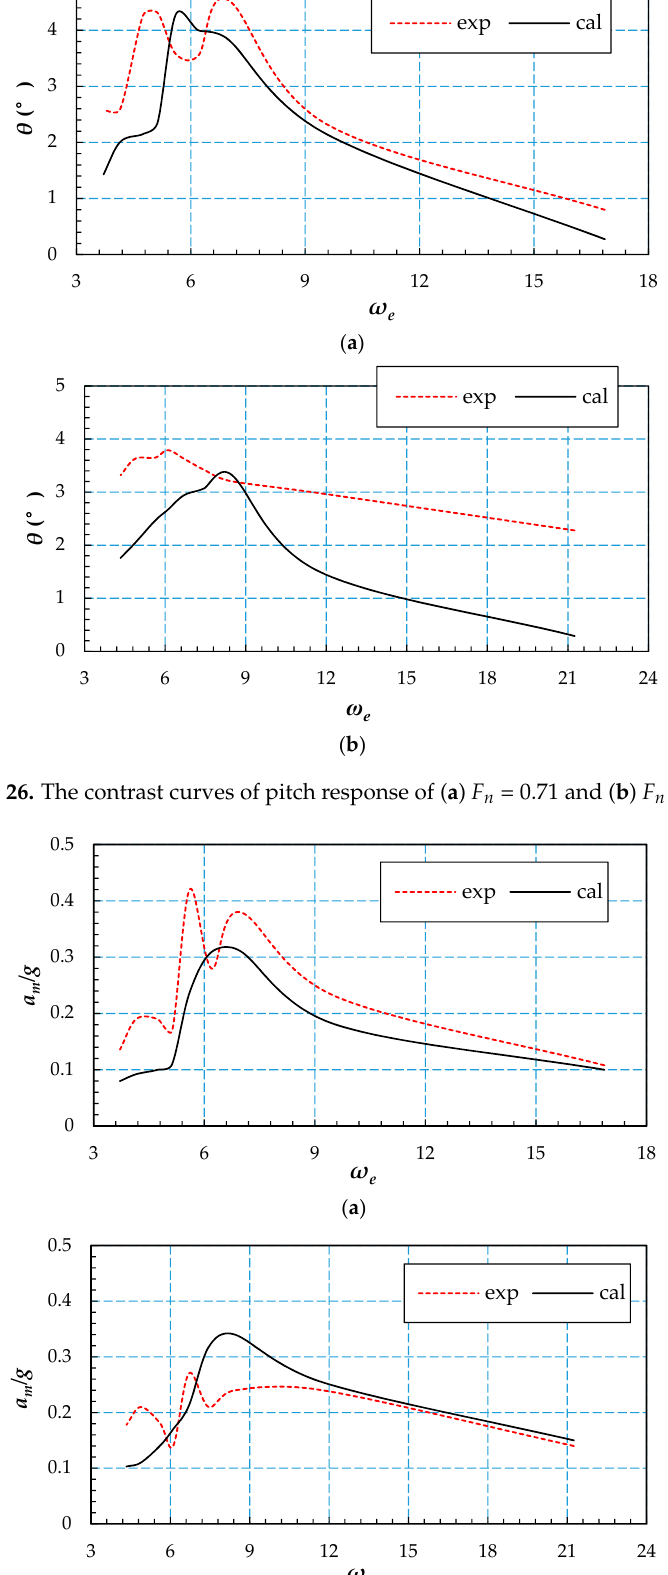
Figure 25. The contrast curves of heave response of ( a ) F n = 0.71 and ( b ) F n = 0.99.